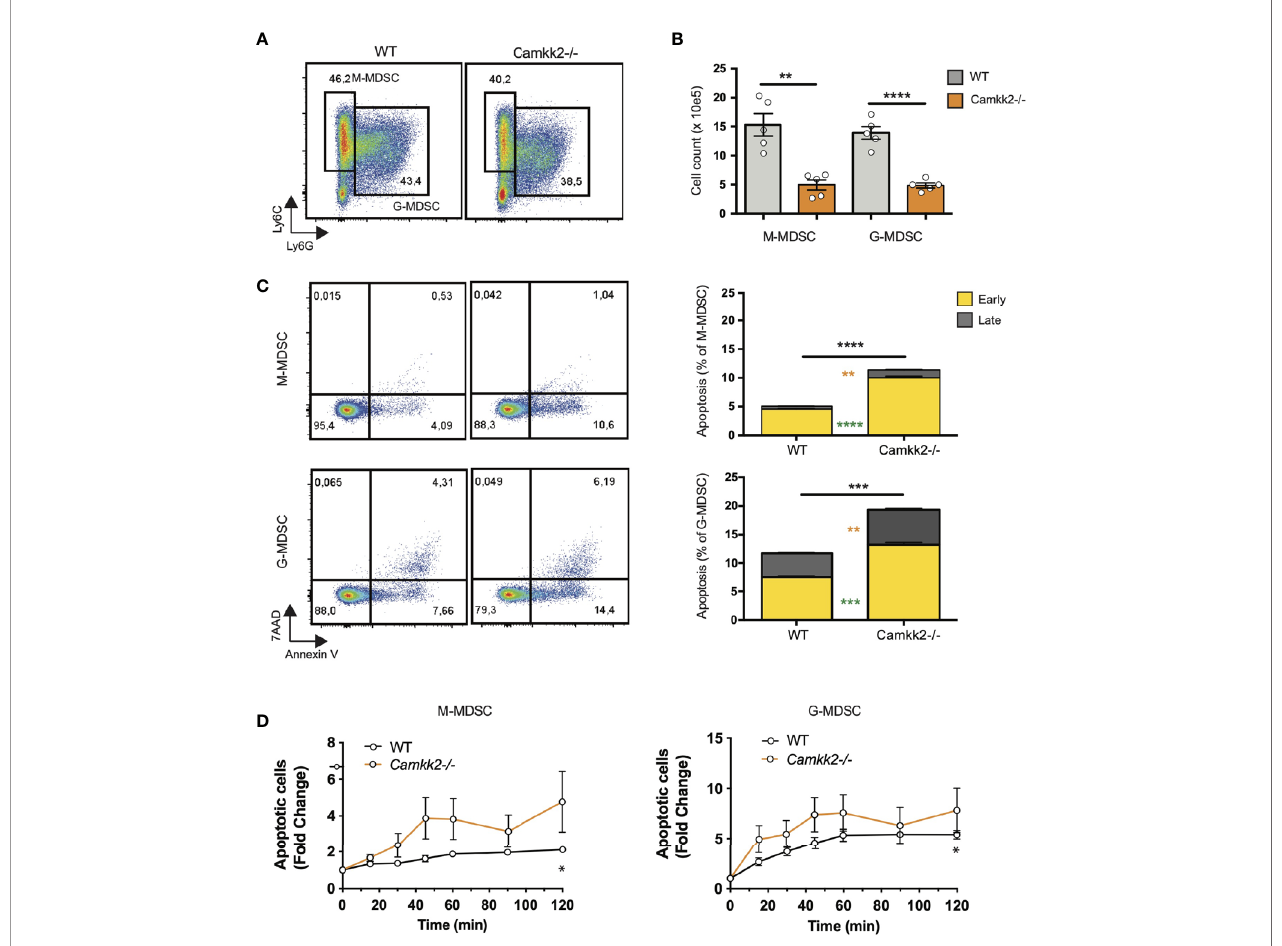
FIGURE 4 | Deletion of Camkk2 impairs the survival of MDSC. Bone marrow cells from WT and Camkk2 -/- mice were cultured with GM-CSF/IL6 cytokines in the absence or presence of E.G7-OVA tumor conditioned medium (30% v/v). After 4 days, cells were collected, stained, and analyzed by fl ow cytometry. (A) Gating strategy and representative FACS pro fi les. (B) Yield of WT and Camkk2 -/- M-MDSC, G-MDSC, and DC. (C) Percentage of early and late apoptotic MDSC. N = 5 biological replicates/group. (D) Bone marrow nucleated cells from WT and Camkk2 -/- mice were cultured with GM-CSF/IL6 cytokines in the absence or presence of E.G7-OVA tumor conditioned medium (30% v/v). MDSC were collected after 48 hours of culture and exposed to 1 m M H 2 O 2 . Apoptotic cells were identi fi ed by fl ow cytometry at the indicated time points. *, **, ***, and **** refer to p<0.05, p< 0.01, p<0.001, p<0.0001, respectively. T-test and two-ways ANOVA were used to calculate p-values in panels B and D,